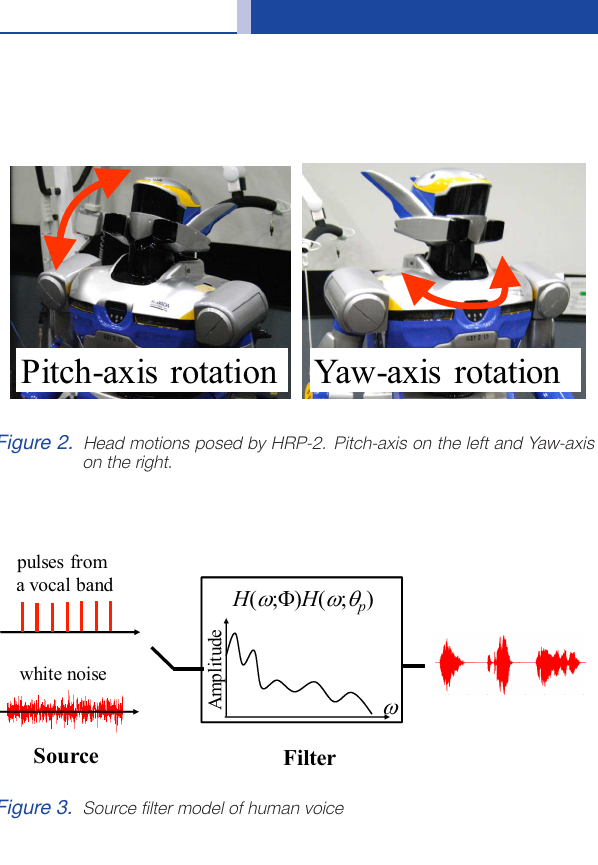
Figure 5. q p –gain model for three